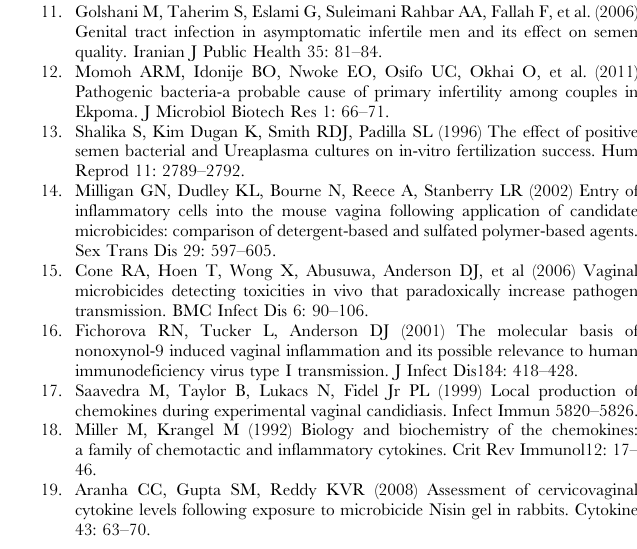
Figure S1 Spermagglutination observed 4h after mixing of human spermatozoa with S. aureus isolate (original magnification 400X). Figure S2 No spermagglutination observed 4h after mixing of human spermatozoa with standard S. aureus MTCC6625 (original magnification 400X).